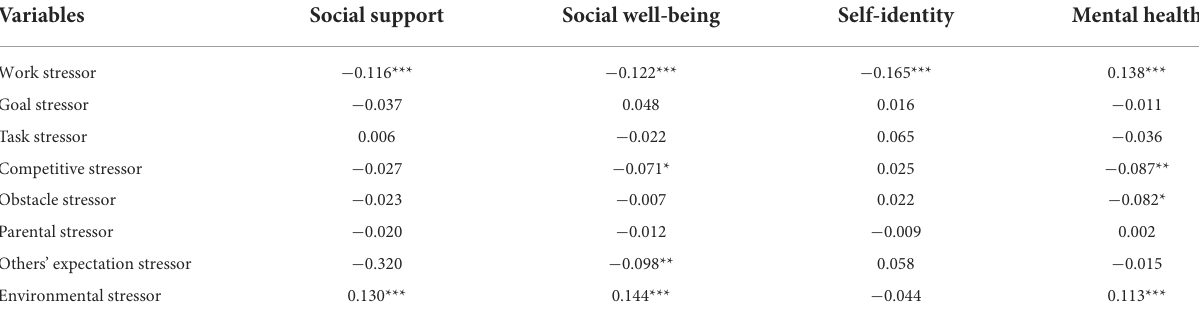
TABLE 3 Partial correlation analysis results.